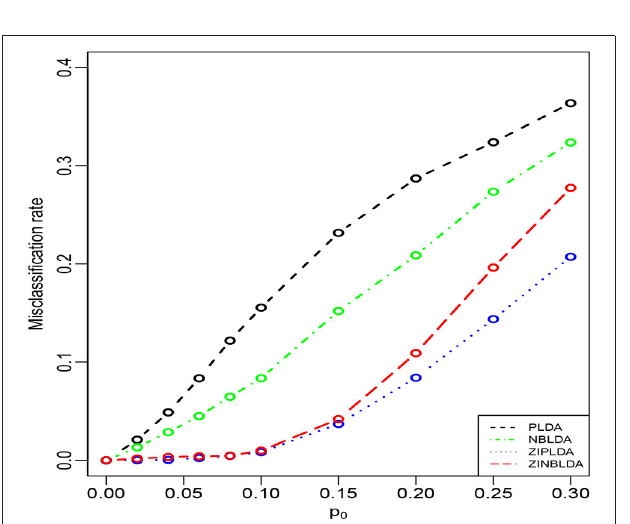
FIGURE 4 | The misclassification rates of the four methods with different sample sizes (Study 3). Here, σ = 0.2, p = 100, φ = 0, p 0 = 0.3, and DE rate = 0.2.